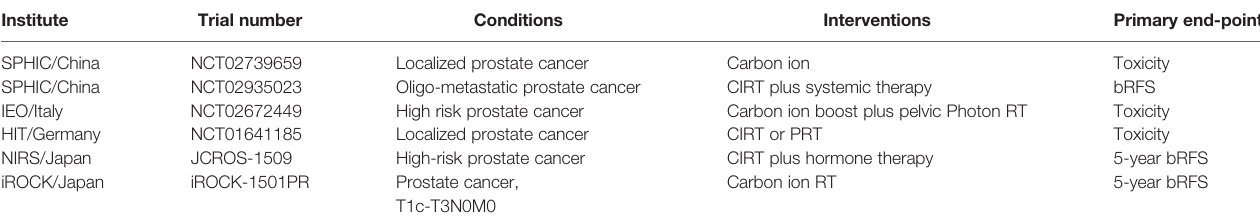
TABLE 2 | Clinical trials of prostate cancer with carbon ion